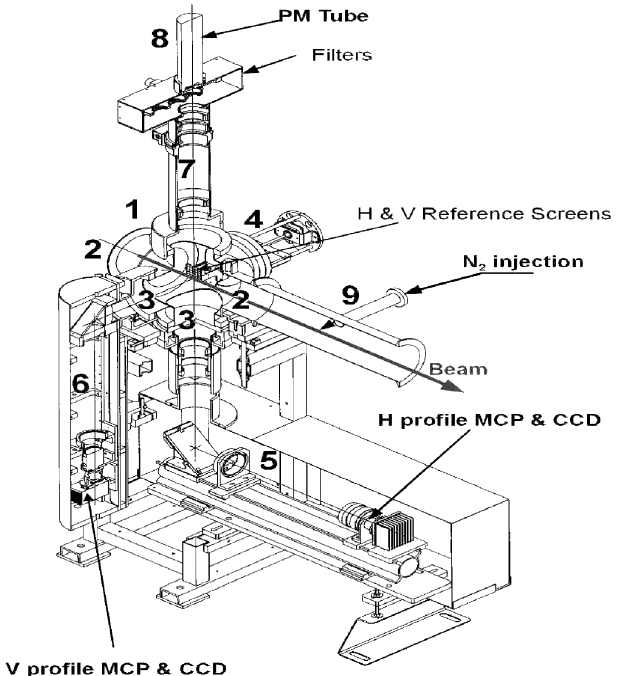
FIG. 3. (Color) The BPL experimental setup installed in the SPS ring: (1) vacuum tank, (2) the ports dedicated to the beam passage, (3) H and V optical windows for light extraction and beam imaging, (4) calibration reference screens, (5) H profile optical setup, (6) V profile optical setup, (7) optical channel for the counting experiment, (8) photomultiplier, (9) gas injecting channel.